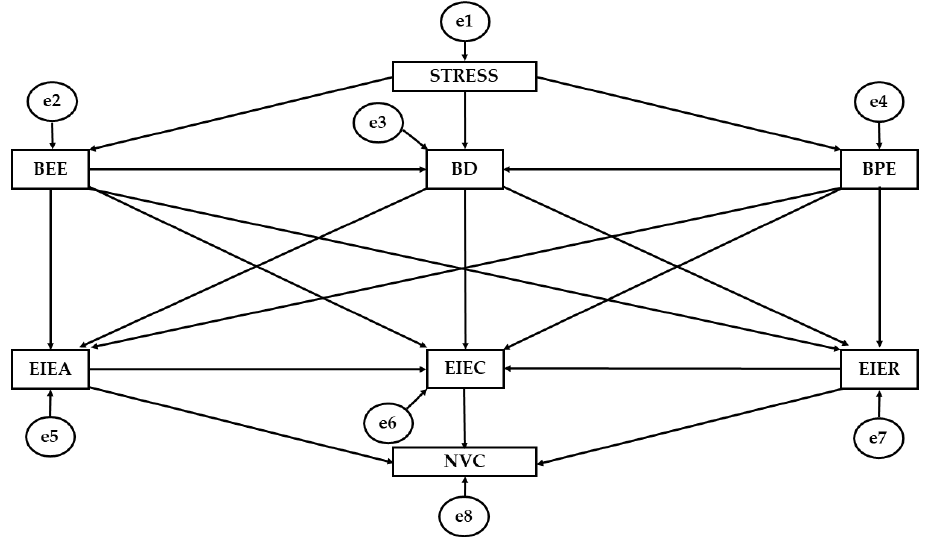
Figure 1. Theoretical structural equation model. Note: BEE, emotional exhaustion; BD, depersonalization/cynicism; BPE, personal efficacy; EIEA, emotional attention; EIEC, emotional clarity; EIER, emotional repair; NVC, non-verbal communication.